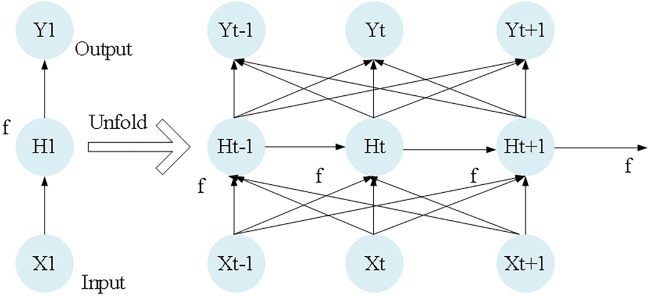
Structure diagram of RNN neural network.